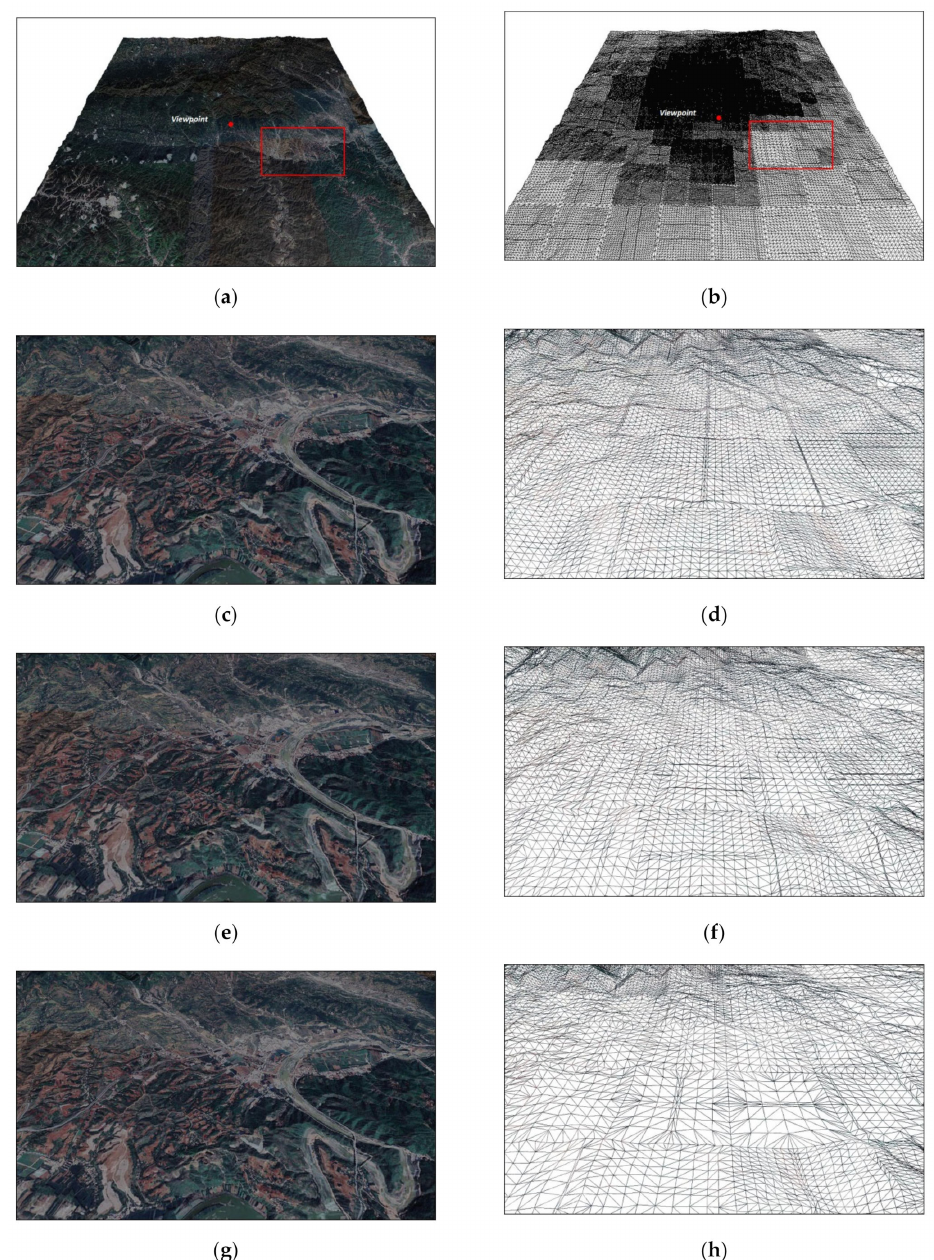
Figure 16. Influence of different adjustment parameters on terrain subdivision. ( a , b ) show the region we select to verify the effect of different adjustment parameters. ( c , d ) C 3 = 10, C 4 = 1. ( e , f ) C 3 = 12.5, C 4 = 0.5. ( g , h ) C 3 = 15, C 4 =